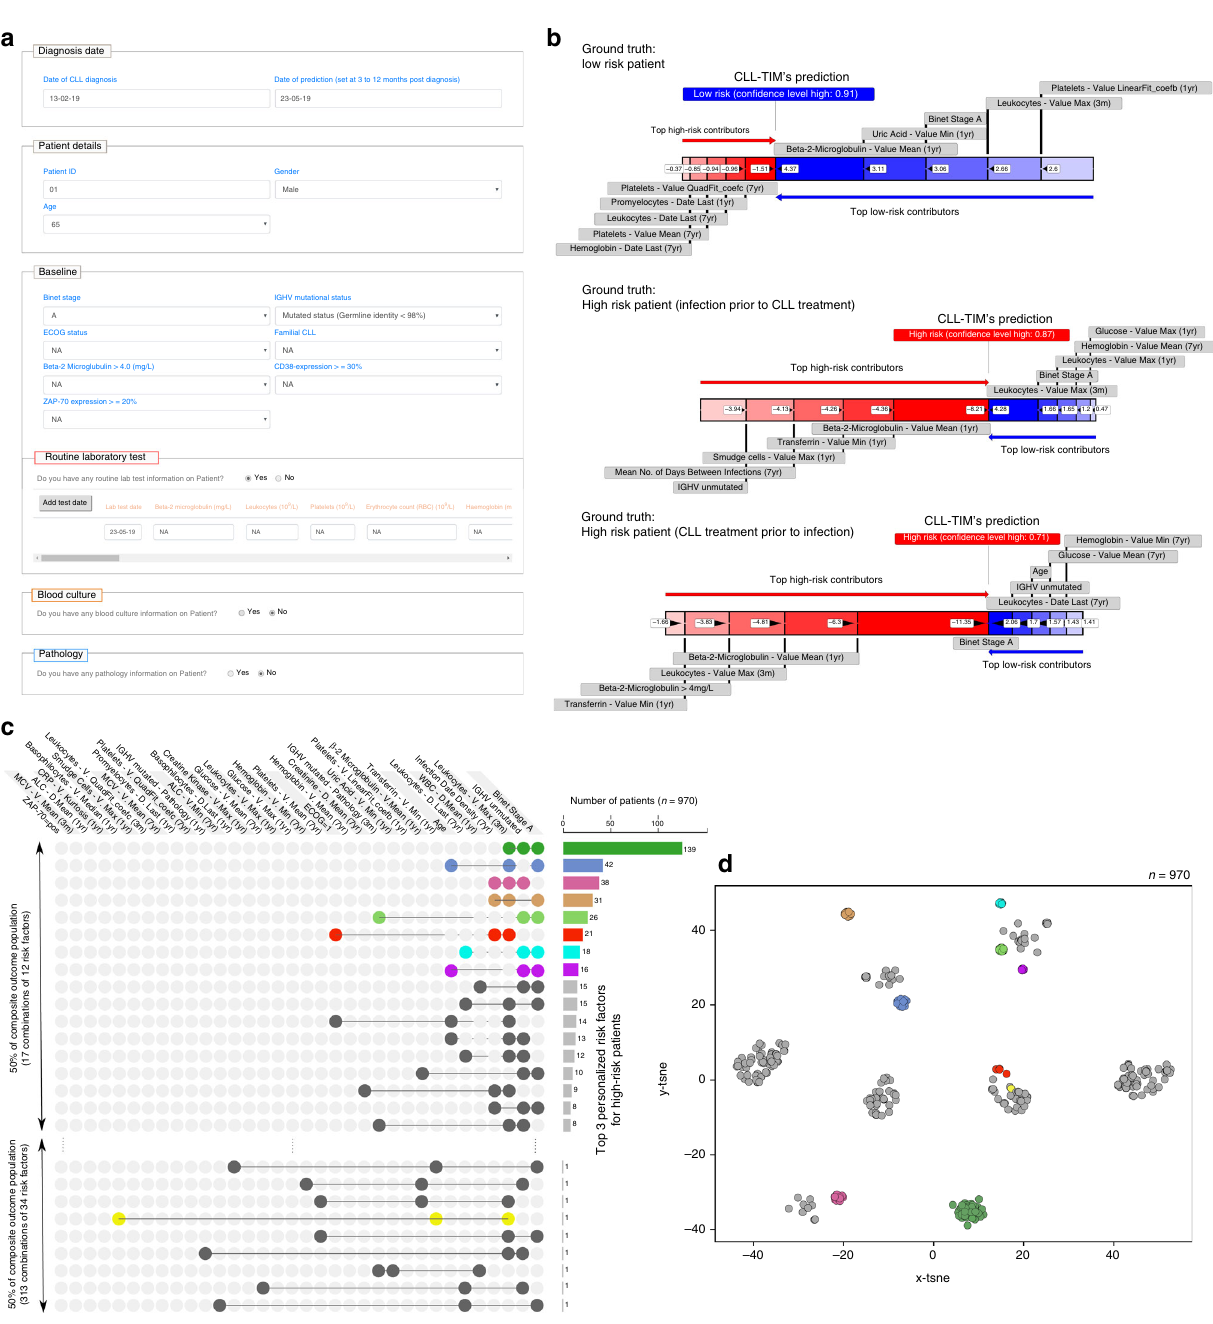
Fig. 9 Analysis of personalized risk factors shows multiple paths towards risk of a composite event. a Input interface of CLL-TIM webserver. CLL-TIM may be used with any patient data available and after data input, the physician is provided with: the predicted risk (high or low) of a composite event within the next 2 years; a con fi dence value indicating the reliability of the given patient prediction; a set of risk factors speci fi c to that patient that were responsible in driving the patient towards their predicted risk. b Personalized risk factors provided by CLL-TIM ’ s webserver. Examples are for three patients in the internal test cohort for which CLL-TIM correctly predicted the outcome of, with high con fi dence. CLL-TIM ’ s probabilistic outputs were 0.09 (low-risk, high- con fi dence) for the fi rst patient, and 0.87 and 0.71 (high-risk, high-con fi dence) for the remaining two patients. To calculate these risk factors, for each patient, the average SHAP value for each of CLL-TIM ’ s 228 features was extracted and averaged across the 28 base-learners of CLL-TIM. The features were then positively and negatively ranked to extract the top 5 features pushing the patient towards high-risk and those pushing the patient towards low- risk. c Co-occurrence of the top personalized high-risk factors. All features that were in the top 3 personalized high-risk factors for the 970 patients in the entire Danish cohort with a composite outcome. In total, 970 high-risk patients had 330 unique combinations of 34 features in their top 3 personalized high-risk factors. Figure generated using UpSet web-interface. d t -distributed Stochastic Neighbor Embedding (t-SNE) clustering of the top 3 personalized high-risk factors. t-SNE was performed using scikit-learn with default parameters on the top 3 personalized high-risk factors for 970 patients with a composite outcome. Color coding is according to c